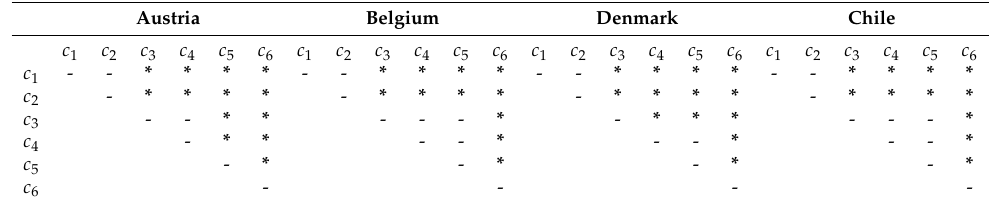
Table 3. Wilcoxon comparison for different probabilities of the movements results. Asterisks indicate each comparison where a statistical difference with 95% confidence was found.